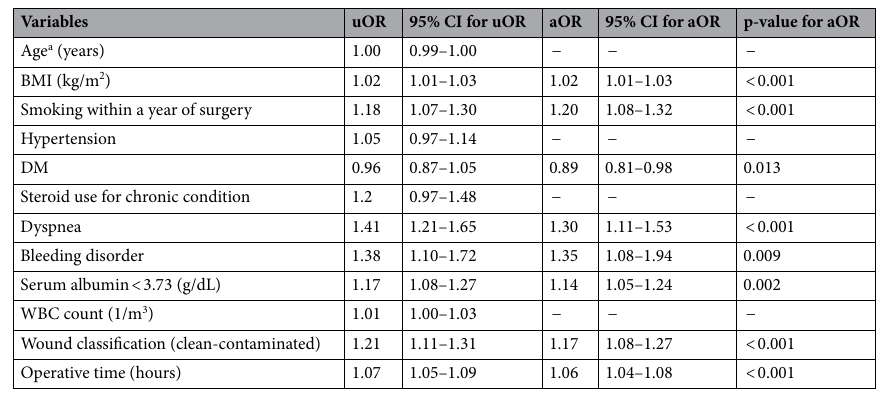
Table 3. Bivariate and multivariate regression analysis results for the for the risk factors of superficial and deep SSIs. Variables dropped from the model due to insignificance at the multivariate level: steroid use for chronic condition, hypertension and age. SSI surgical site infection, uOR unadjusted odds ratio, aOR adjusted odds ratio, CI confidence interval, BMI body mass index, DM diabetes mellitus, WBC white blood cells. a With patients over 89 coded as 90+.